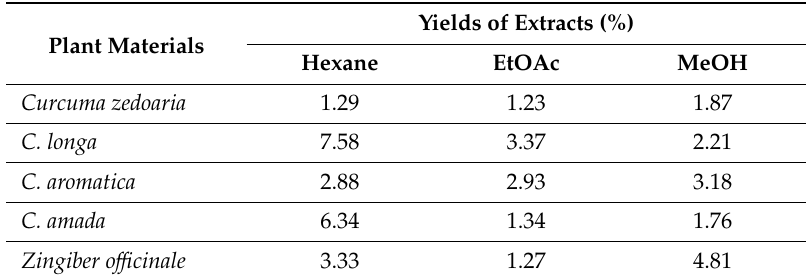
Table 2. Yields of Zingiberaceae extracts for screening tests. Yields of Extracts Plant Materials